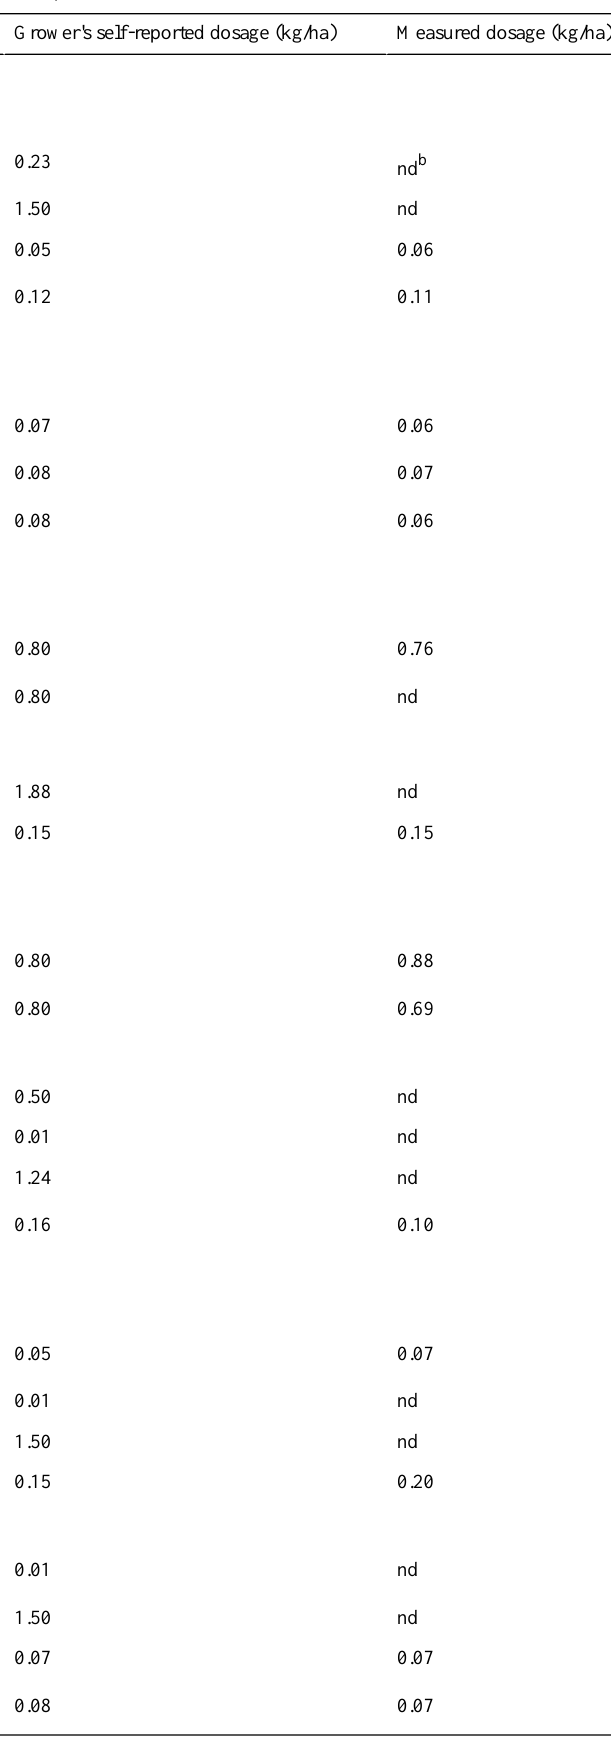
Table 2. Selected fields and respective applications with reported and measured pesticide concentrations in the tank